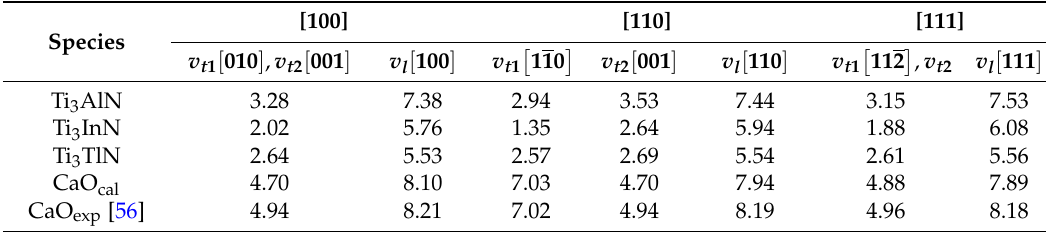
Table 4. Anisotropy acoustic wave speed of Ti 3 AN (km · s − 1